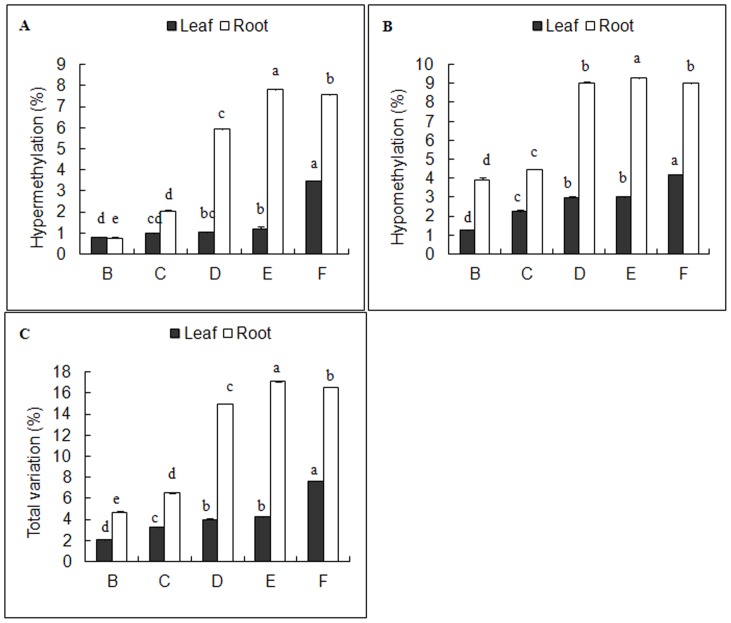
Effects of different salt stresses on variations in C.virgata leaves and roots.B: NaCl, C: Na2SO4, D: NaHCO3, E: Na2CO3, F: Mix. Data represent means ±S.E. of four replicates. Different lower-case letters represent significant difference among treatments at the 5% level, according to least significant difference (LSD) test.